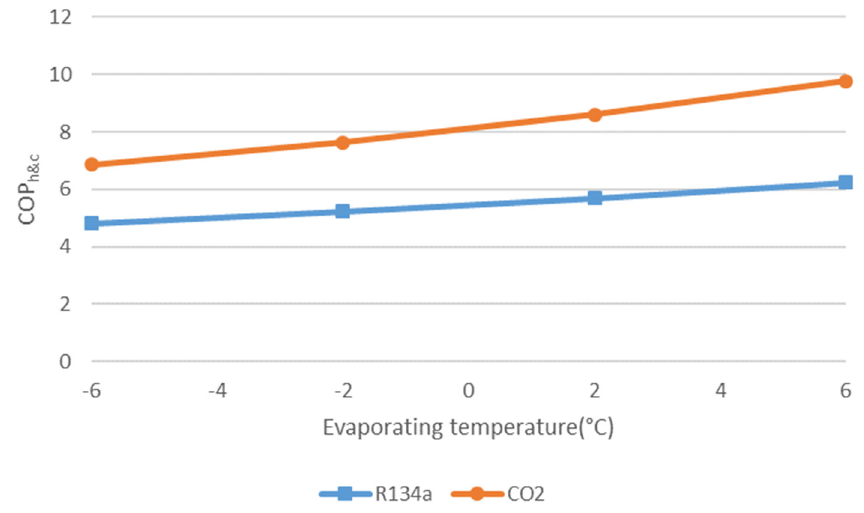
Figure 12. Comparison of cycle COPs in different operating modes.